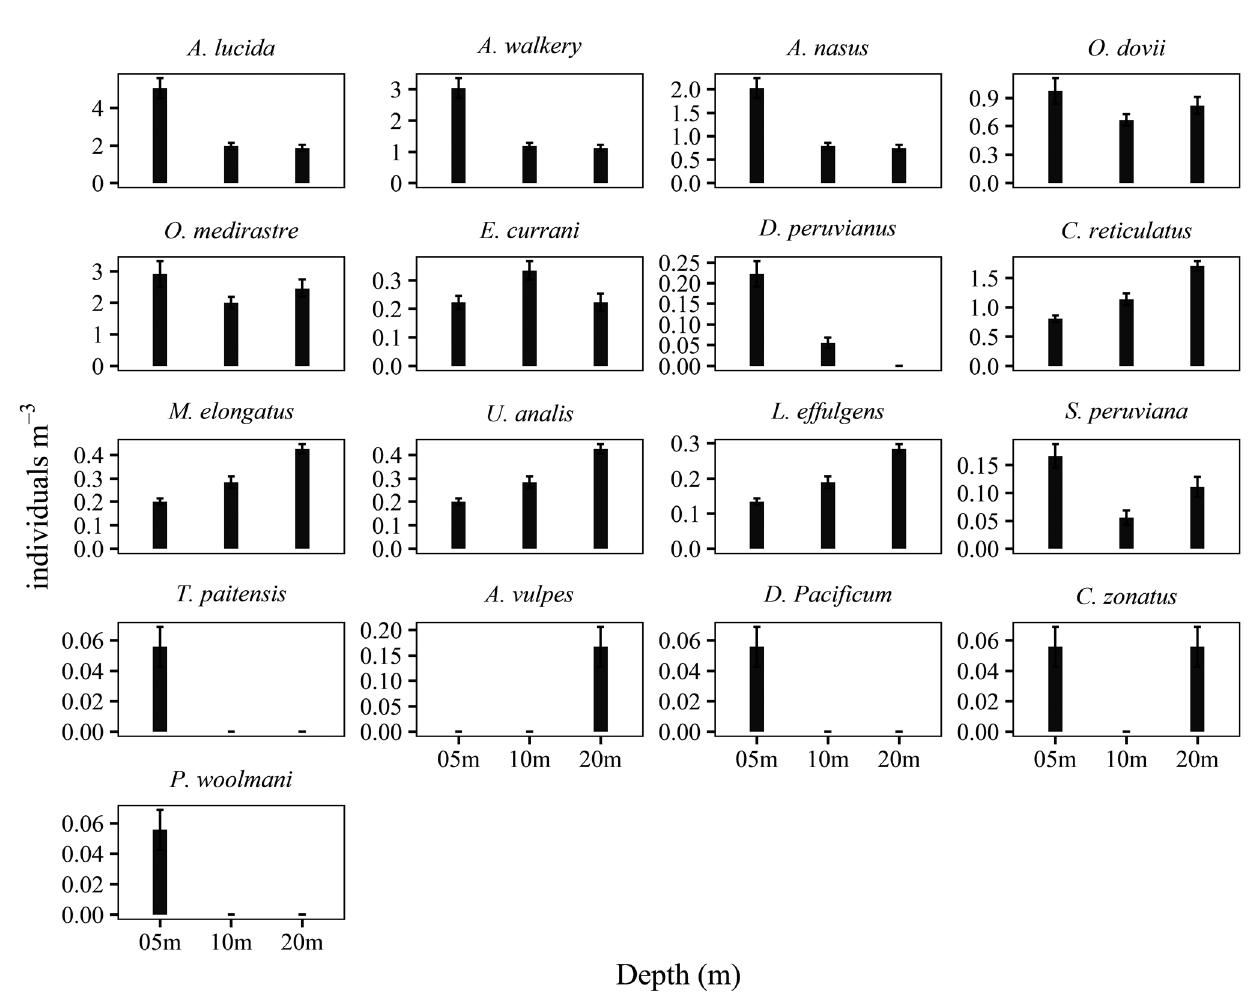
FIGURE 7 | Vertical distribution of the abundance of the species found in the study. Bars indicate the mean value (individuals m -3 ) and error bars the Standard